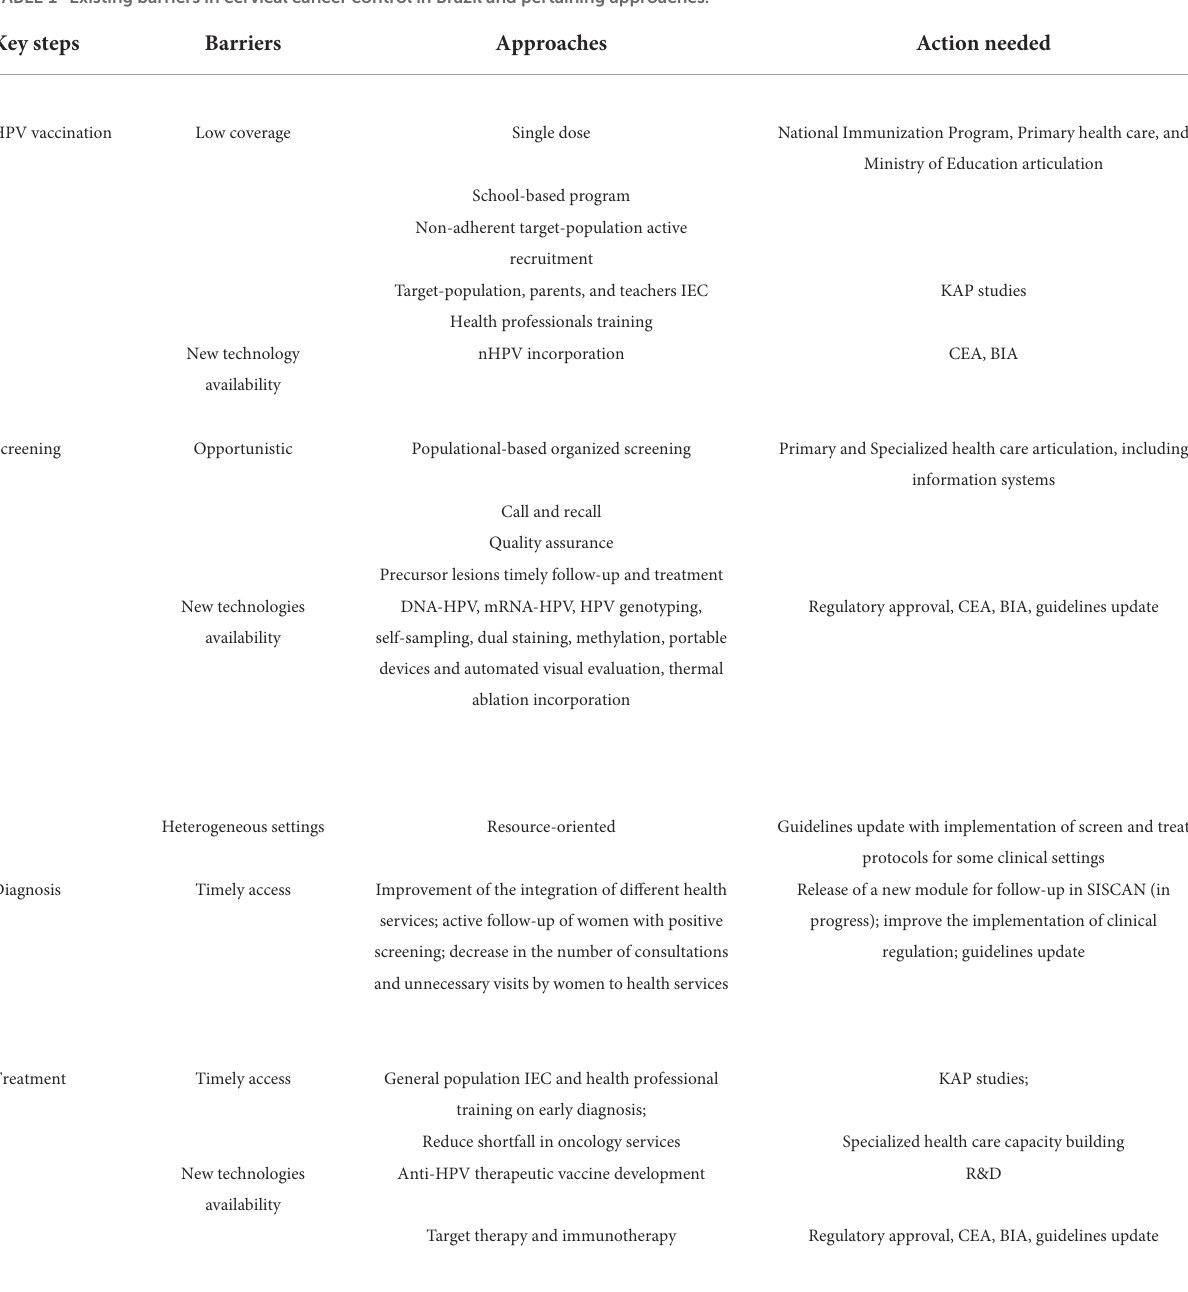
TABLE 1 Existing barriers in cervical cancer control in Brazil and pertaining